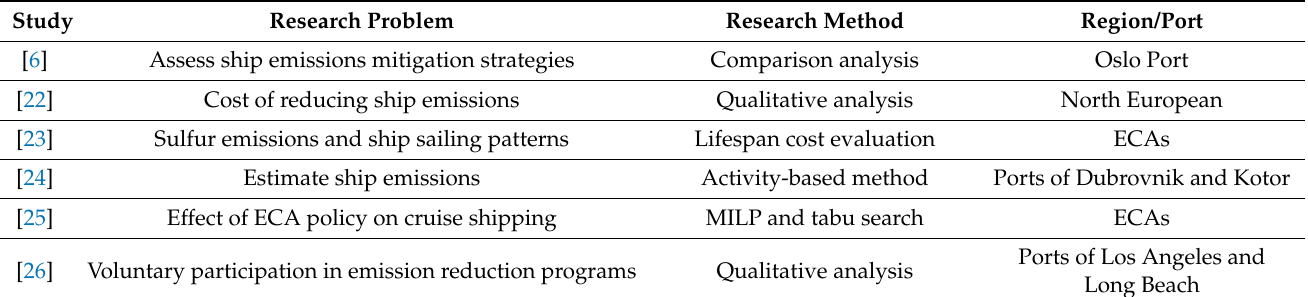
Table 1. Studies on ship emission and